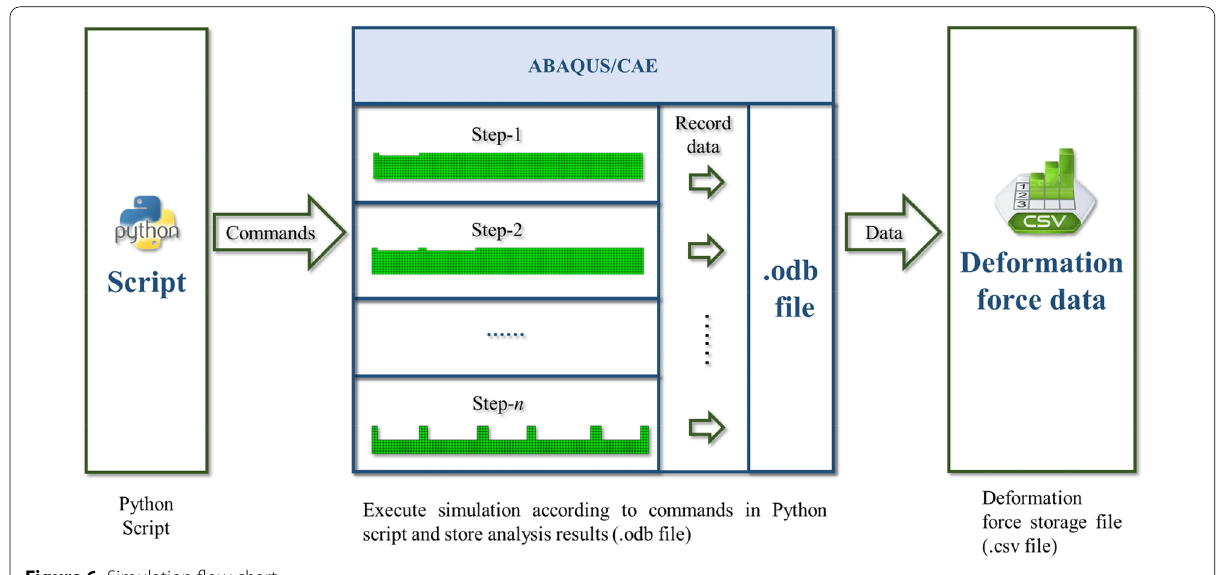
Figure 6 Simulation flow chart